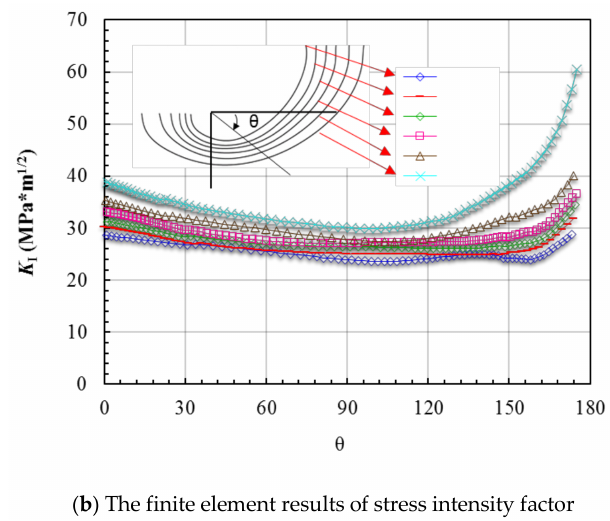
Figure 20. Modified stress intensity factor prediction by empirical formula in the following part of trace lines of the third stage. (The di ff erent color lines represent di ff erent crack front.). Table 9. Stress intensity factor comparison between empirical formula and finite element